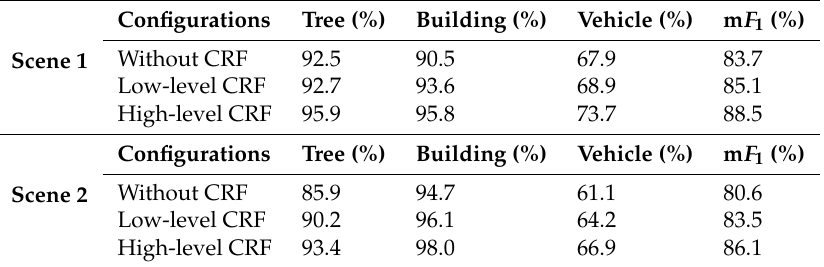
Table 5. Classification performance of methods ( F 1 -score and m F 1 ) with three